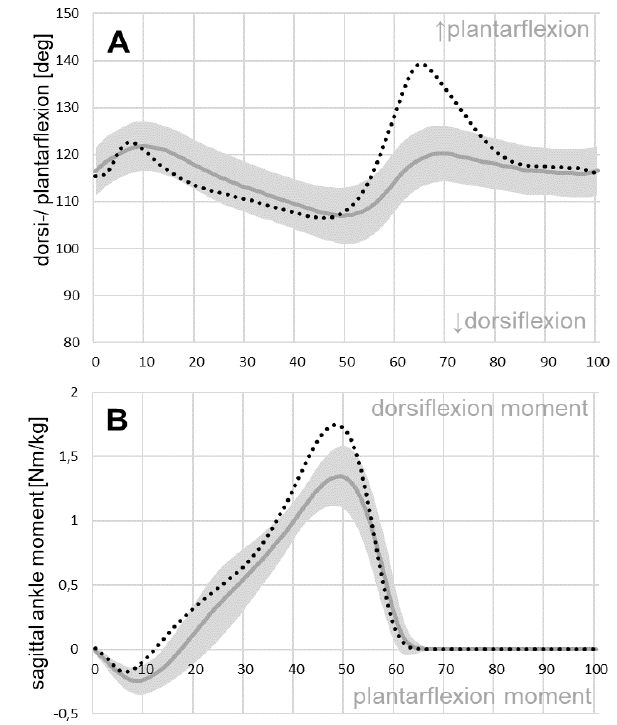
Figure 1: Mean parameters for the prosthetic side foot/ankle of the TTs with standard deviation (grey) and for the control group (dotted, black). A: mean pattern of foot/ankle motion, B: external sagittal moment acting on the ankle joint .